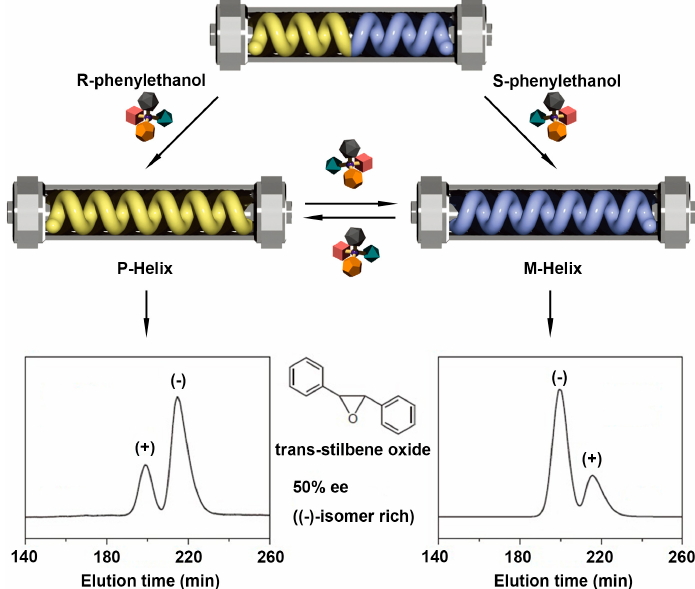
Figure 7. Schematic illustration of switchable enantioseparation (trans-stilbene oxide) by poly-1 stationary phase. Through R / S -phenylethanol stimulus, the original racemic helicity can turn into P-helix or M-helix, generating a great impact on the elution order of trans-stilbene oxide enantiomers. Reproduced from [75] with copyright permission.